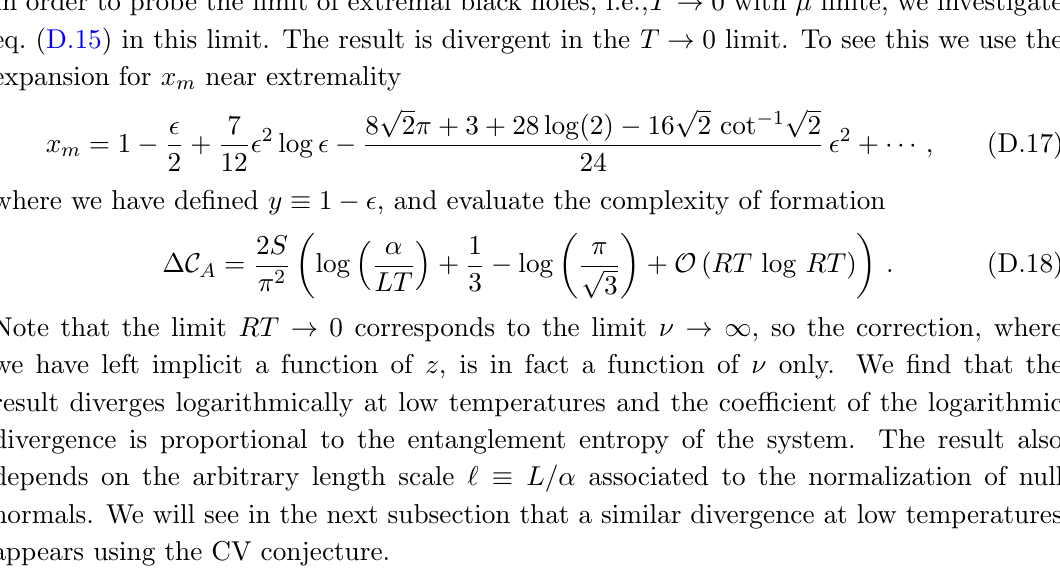
q (cid:22) C J . C T T